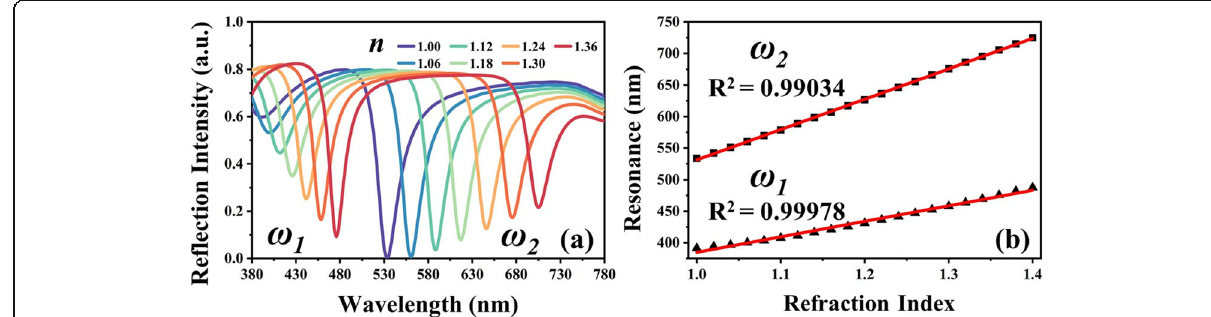
Fig. 6 a Reflection spectra of TAM exposed in surrounding environment with different refraction indexes ( n ). b The relationship of resonances and n values